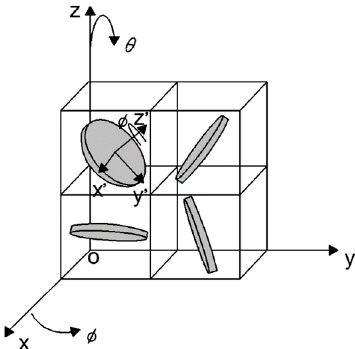
Figure 3. Schematic drawing of the IPD model for 3D distribution of fillers with high aspect ratios [26].